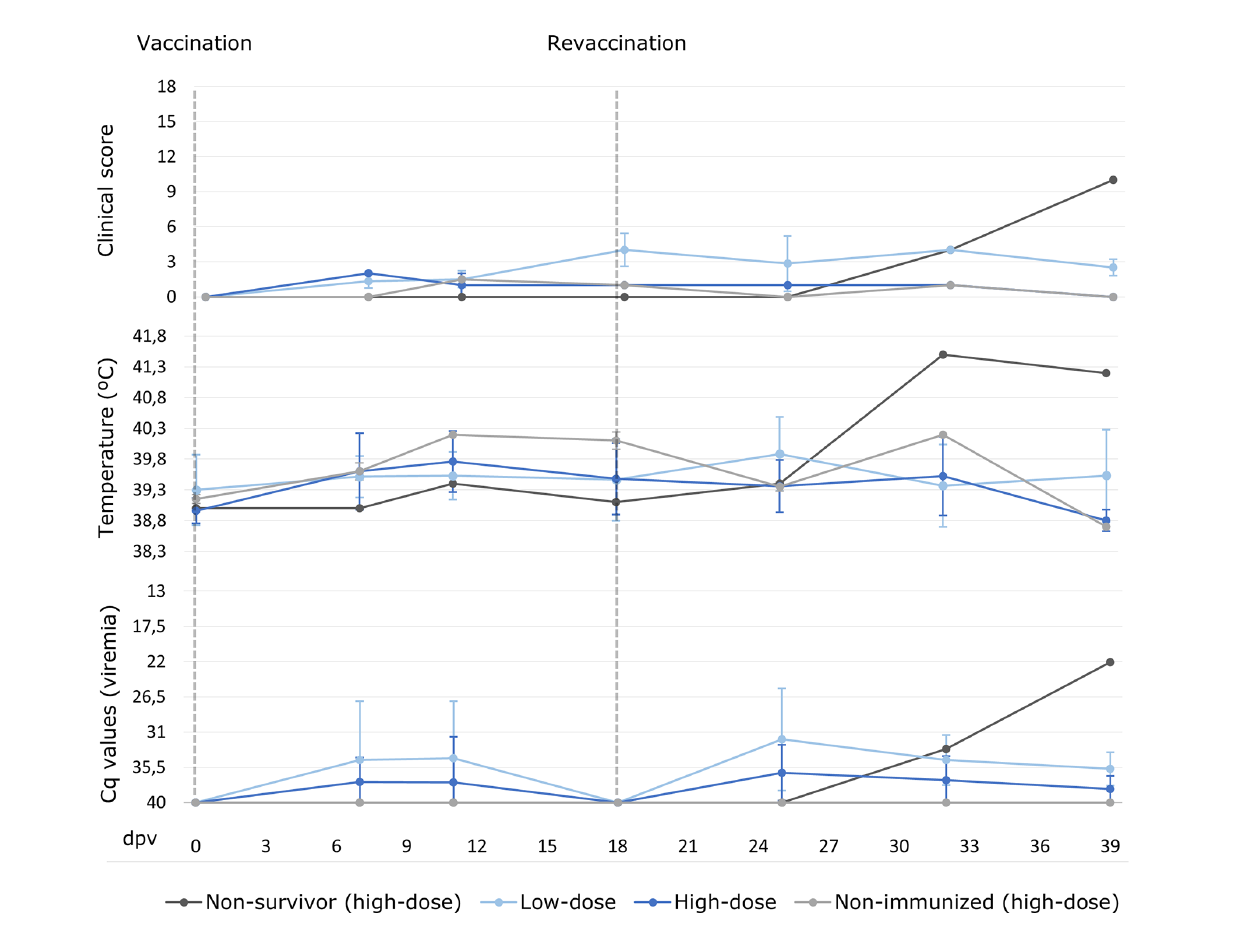
FIGURE 2 | Averages of clinical score, rectal temperature and viremia expressed in cycles of quanti fi cation (Cq) values of real-time PCR carried out for wild boar orally vaccinated with 10 3 TCID 50 (low-dose group; light blue) and 10 4 TCID 50 of Lv17/WB/Rie1 ASFV (high-dose group; dark blue) on the sampling days post- vaccination (dpv). The results obtained for the non-surviving animal from the high-dose group during the vaccination period are presented separately (dark grey). Also, shown separately the two animals from the high-dose group that were non-immunized (light